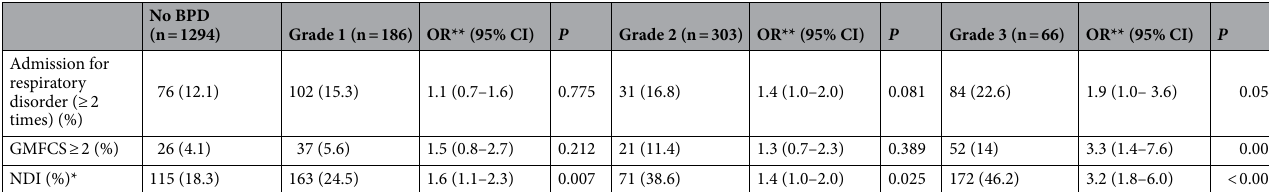
Table 3. Multiple logistic analysis model of the association between BPD grades at 36 weeks PMA according to NRN criteria had long term complications. The odds ratios were calculated using “no BPD” as a reference. NRN Neonatal Research Network, GMFCS Gross Motor Function Classification System, OR odds ratio, CI confidence interval. *NDI (neurodevelopmental impairment) defined as Bayley composite score < 70(II) or < 85(III) or K-DST < -2 standard deviations. **OR is adjusted for cesarean section, maternal hypertension, chorioamnionitis, gestational age, birth weight, sex, RDS, air-leakage, pulmonary hemorrhage, pulmonary hypertension, treated PDA, IVH, NEC, sepsis.